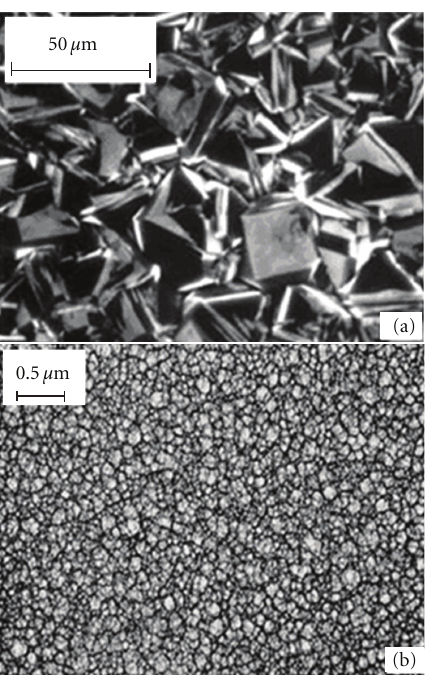
Figure 4: SEM images of (a) a polycrystalline BDD thin film and (b) a nanocrystalline BDD thin film.